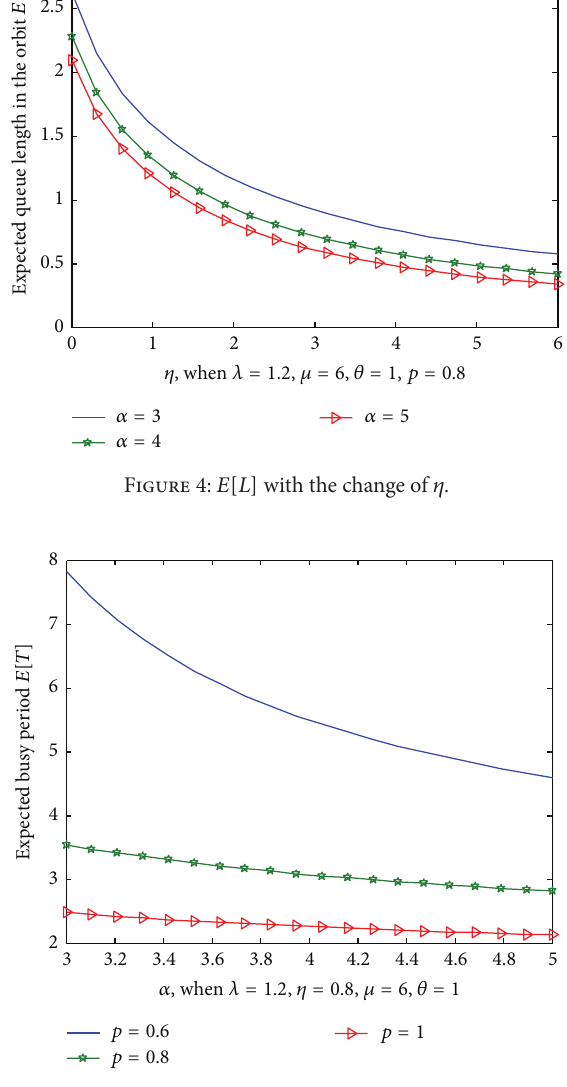
Figure 5: 𝐸[𝑇] with the change of 𝛼 .